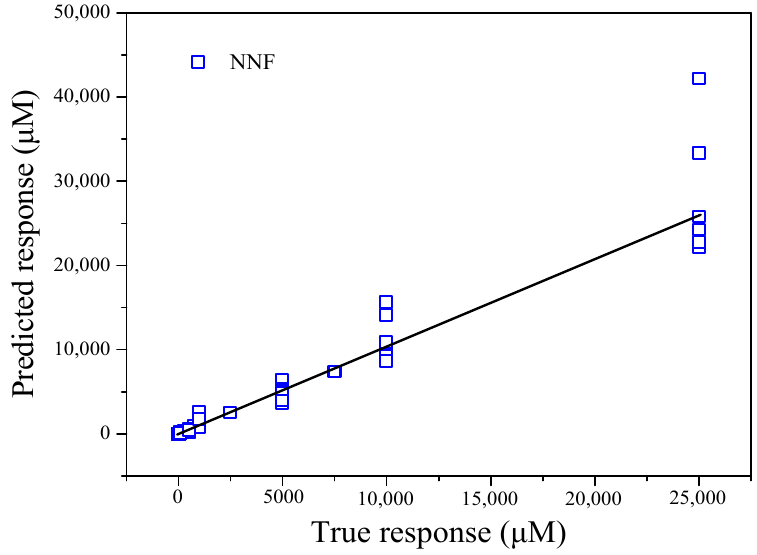
Figure 12. Predicted Ca 2+ concentrations obtained by the established NNF model vs. the actual Ca 2+ concentrations.